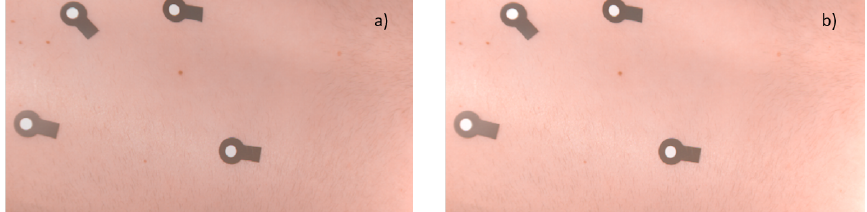
Figure 6. ( a ) RGB (Red Green Blue) color image obtained from the hyperspectral radiance image of subject no. 1. ( b ) a clipped version of image ( a ) with the clip level taken from the brightest